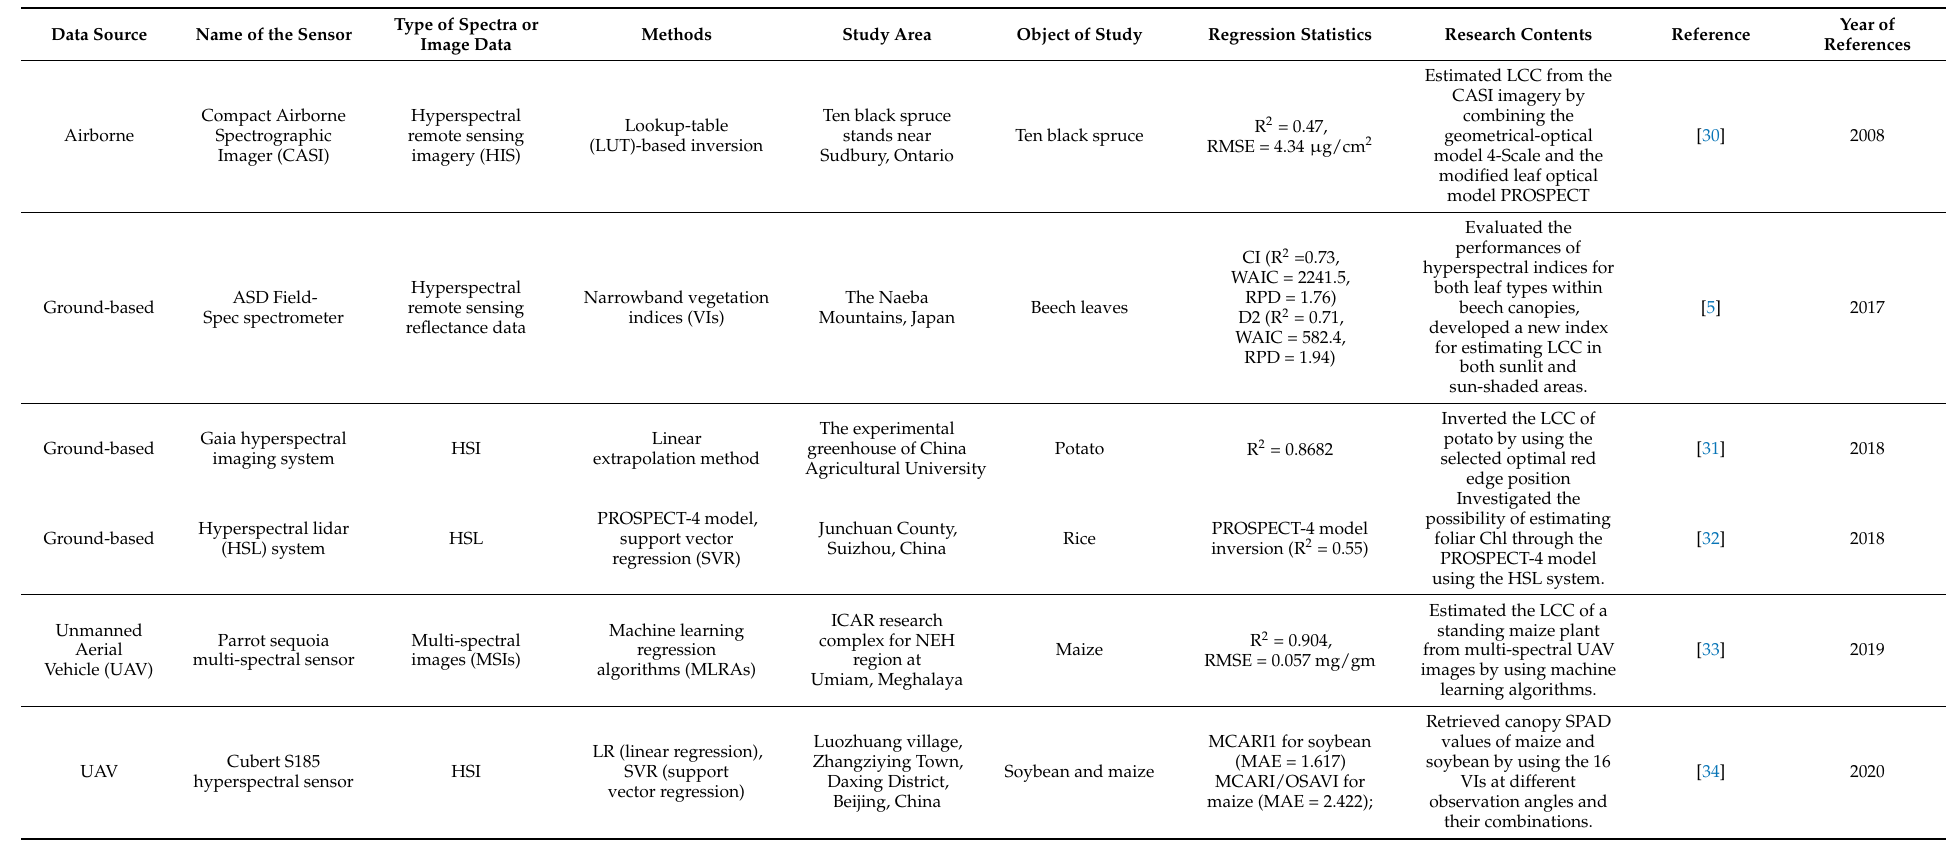
Table 1. Short overview of LCC monitoring through remote